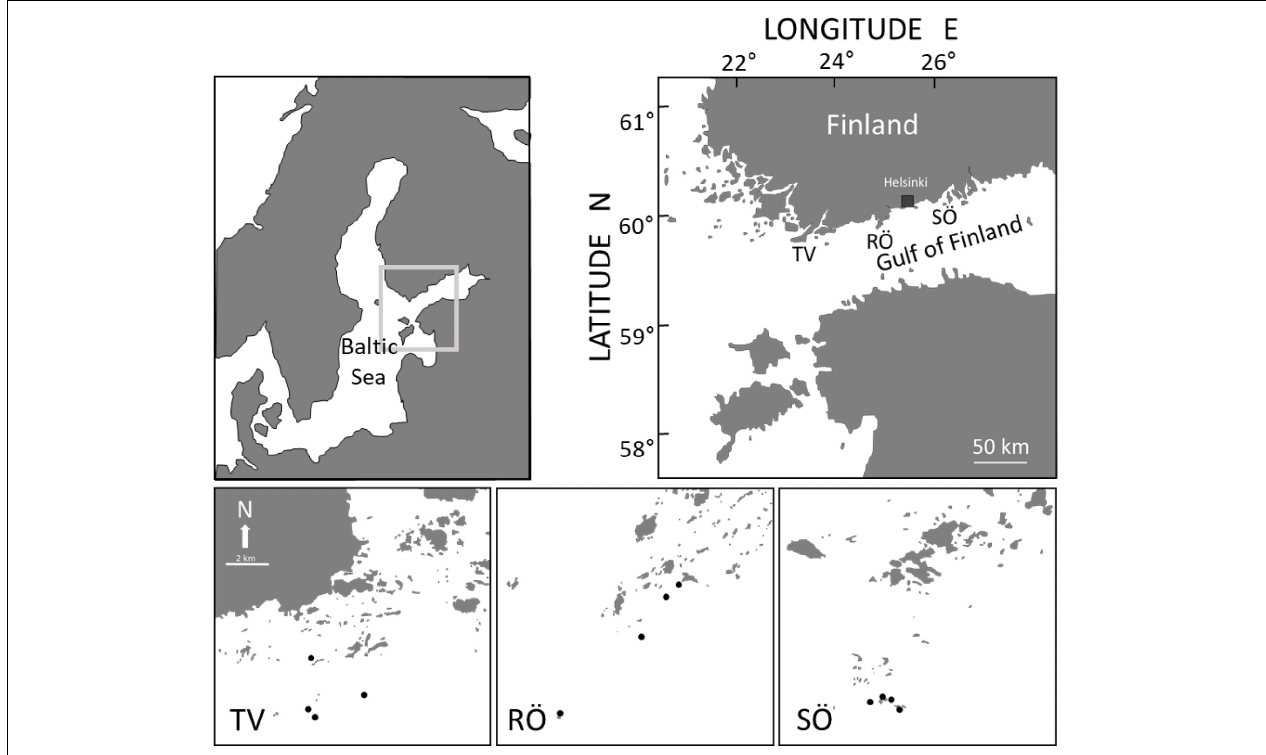
FIGURE 1 | Gulf of Finland and study areas Tvärminne (TV), Rönnskär (RÖ), and Söderskär (SÖ). Distance between areas ca 130 km. Sampling stations are shown in the lower panel. The scale is equal among all figures in the lower panel.